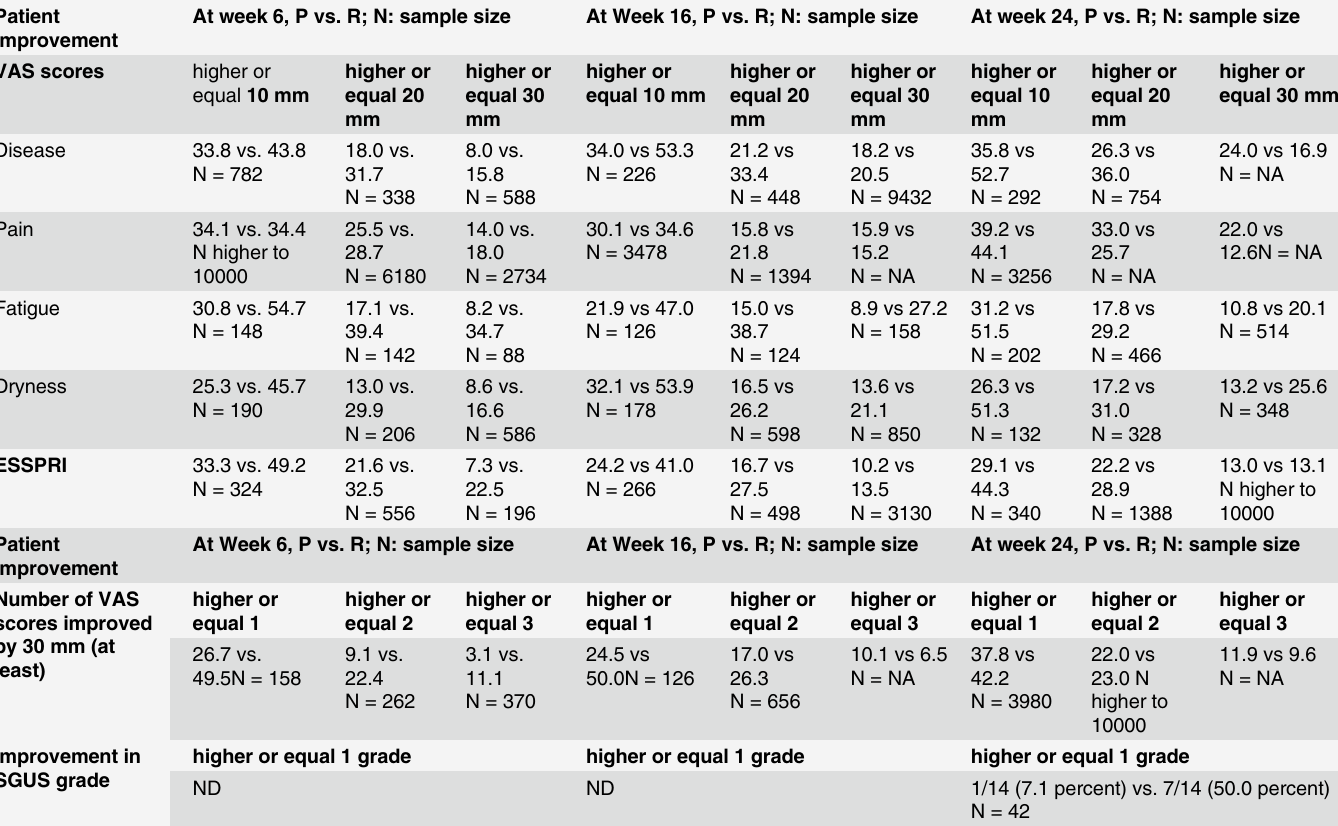
Patient At Week 6, P vs. R; N: sample size At Week 16, P vs. R; N: sample size At week 24, P vs. R; N: sample size improvement Number of VAS scores